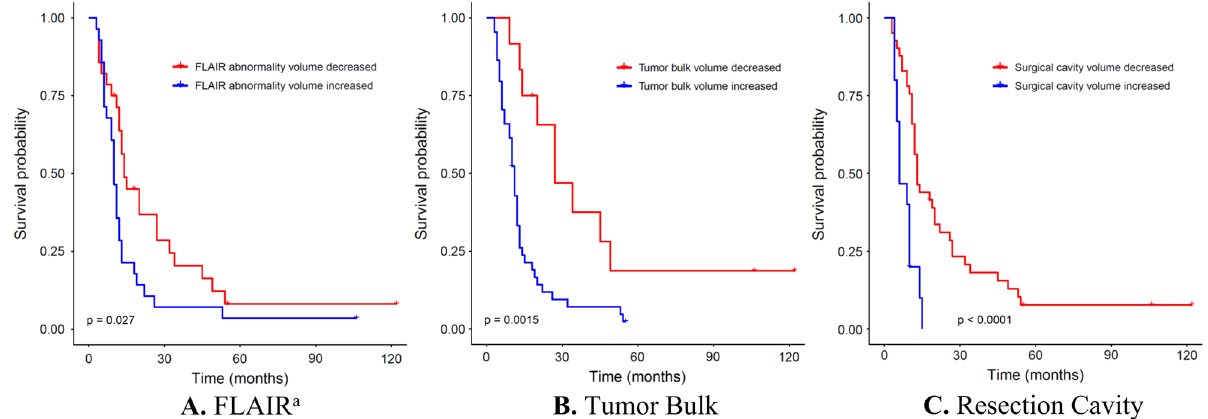
Figure 2. Kaplan–Meier survival curves for volumetric measurements in patients who underwent resection of tumor recurrence with implantation of Gliadel wafers. a T2-Weighted fluid-attenuated inversion